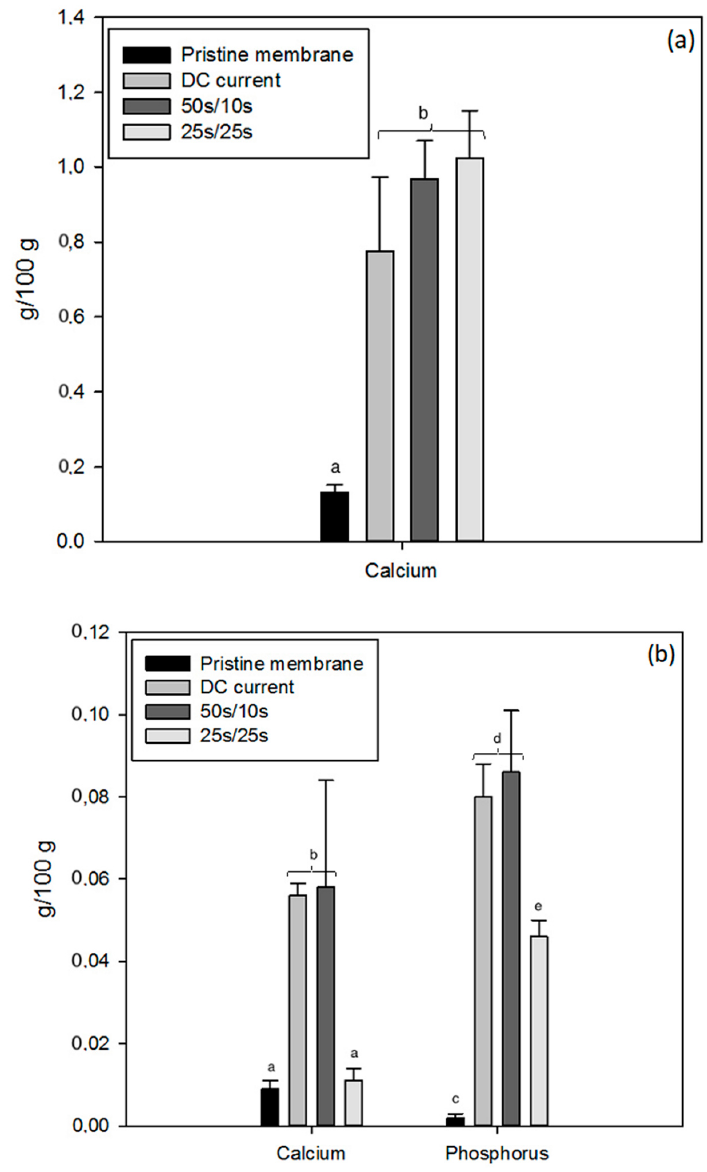
Figure 7. Calcium content of cation-exchange membranes (CEMs) ( a ) and calcium and phosphorus content of AEMs ( b ) for all three current conditions, in comparison with a pristine membrane. Different letters on histograms for each element means that there is a statistical difference between their values (P < 0.05).